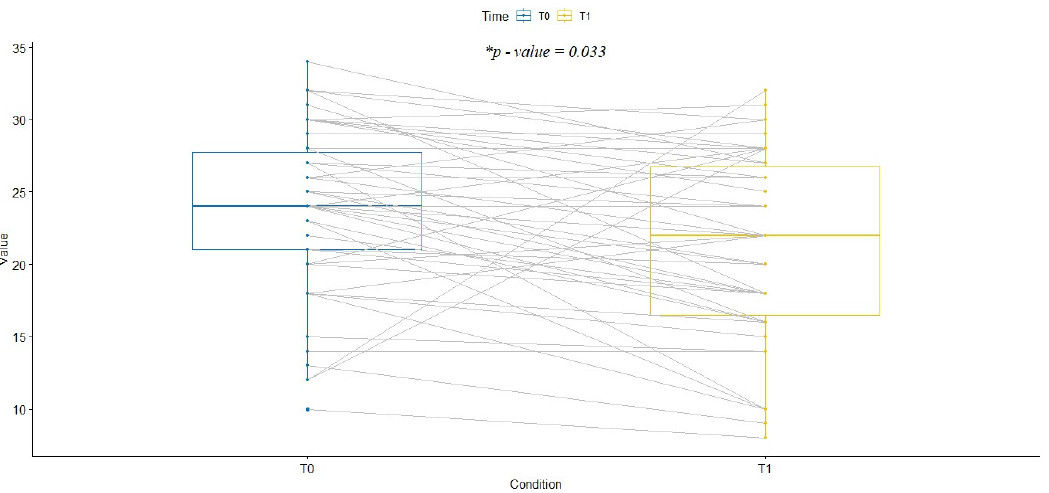
Figure 4. Comparison between LUS score at admission and discharge of surviving patients. The difference is statistically significant (mean difference of 1.75, * p -value = 0.03). LUS = lung